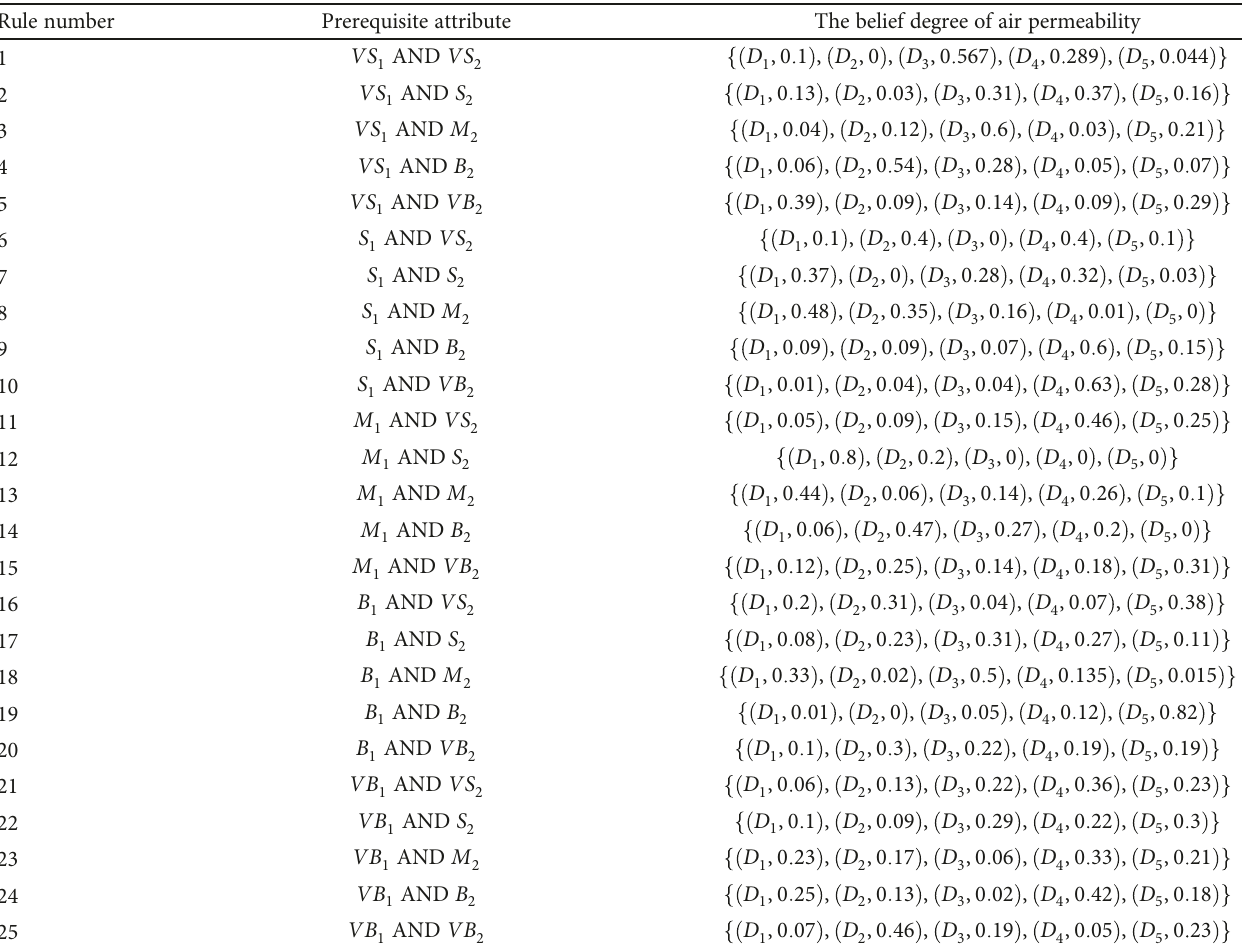
Table 1: The belief